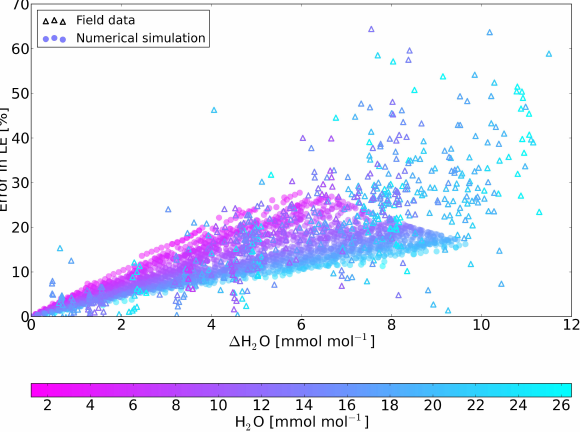
Fig. 7. Latent heat flux error as a function of H 2 O concentration bias, for the LI-7200 field data and for the numerical simulation performed in Sect. 2.1.2. For the field data, flux errors and concen- tration biases are calculated taking the corresponding LI-7000 data as a reference. Colours indicate average baseline